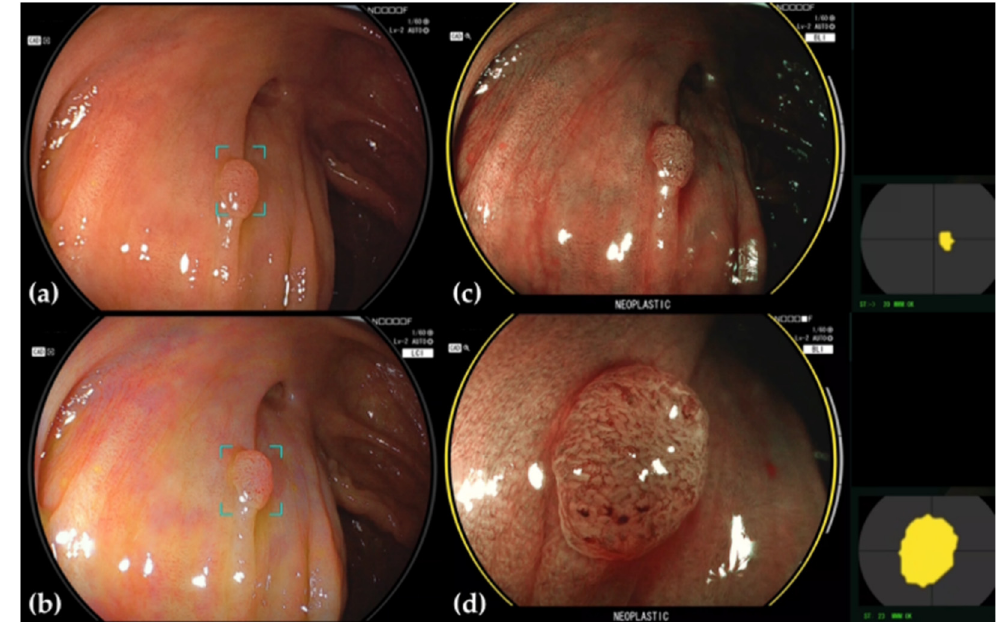
Figure 2. Adenoma detected and diagnosed by CADEYE. ( a ) The margins of the area around a suspected polyp detected under WLE are delineated. ( b ) This area is similarly delineated under LCI. ( c ) If the lesion is determined to be neoplastic under BLI, the endoscopic image is ringed in yellow, and the word “NEOPLASTIC” is displayed beneath. The location where the determination is being conducted is also shown to the right of the endoscopy image. ( d ) Magnified BLI image.